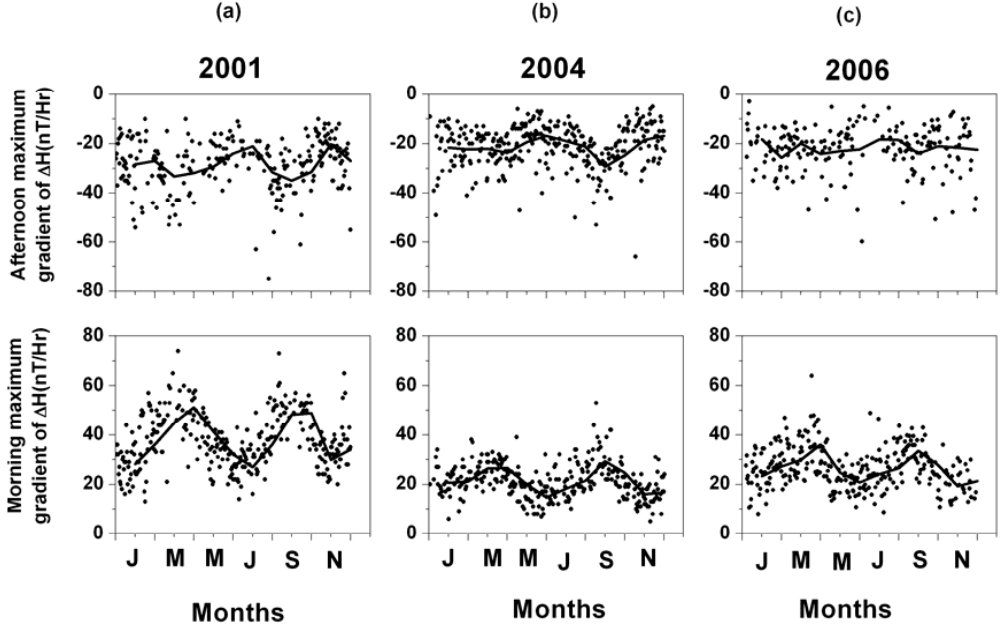
Fig. 2. (a) Daily variations in the morning maximum and afternoon maximum values of d(1H TIR )/dt on all the magnetically quiet days